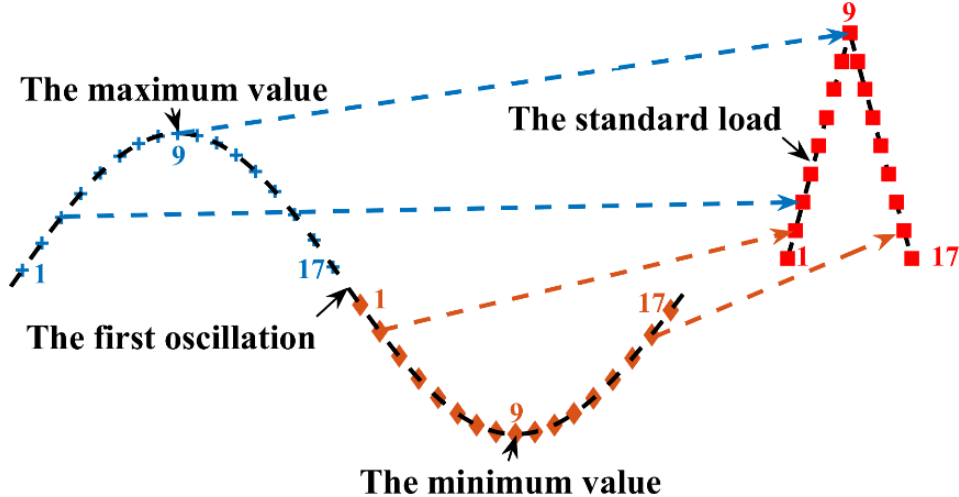
Figure 16. Mapping relationship between response signal and standard load.